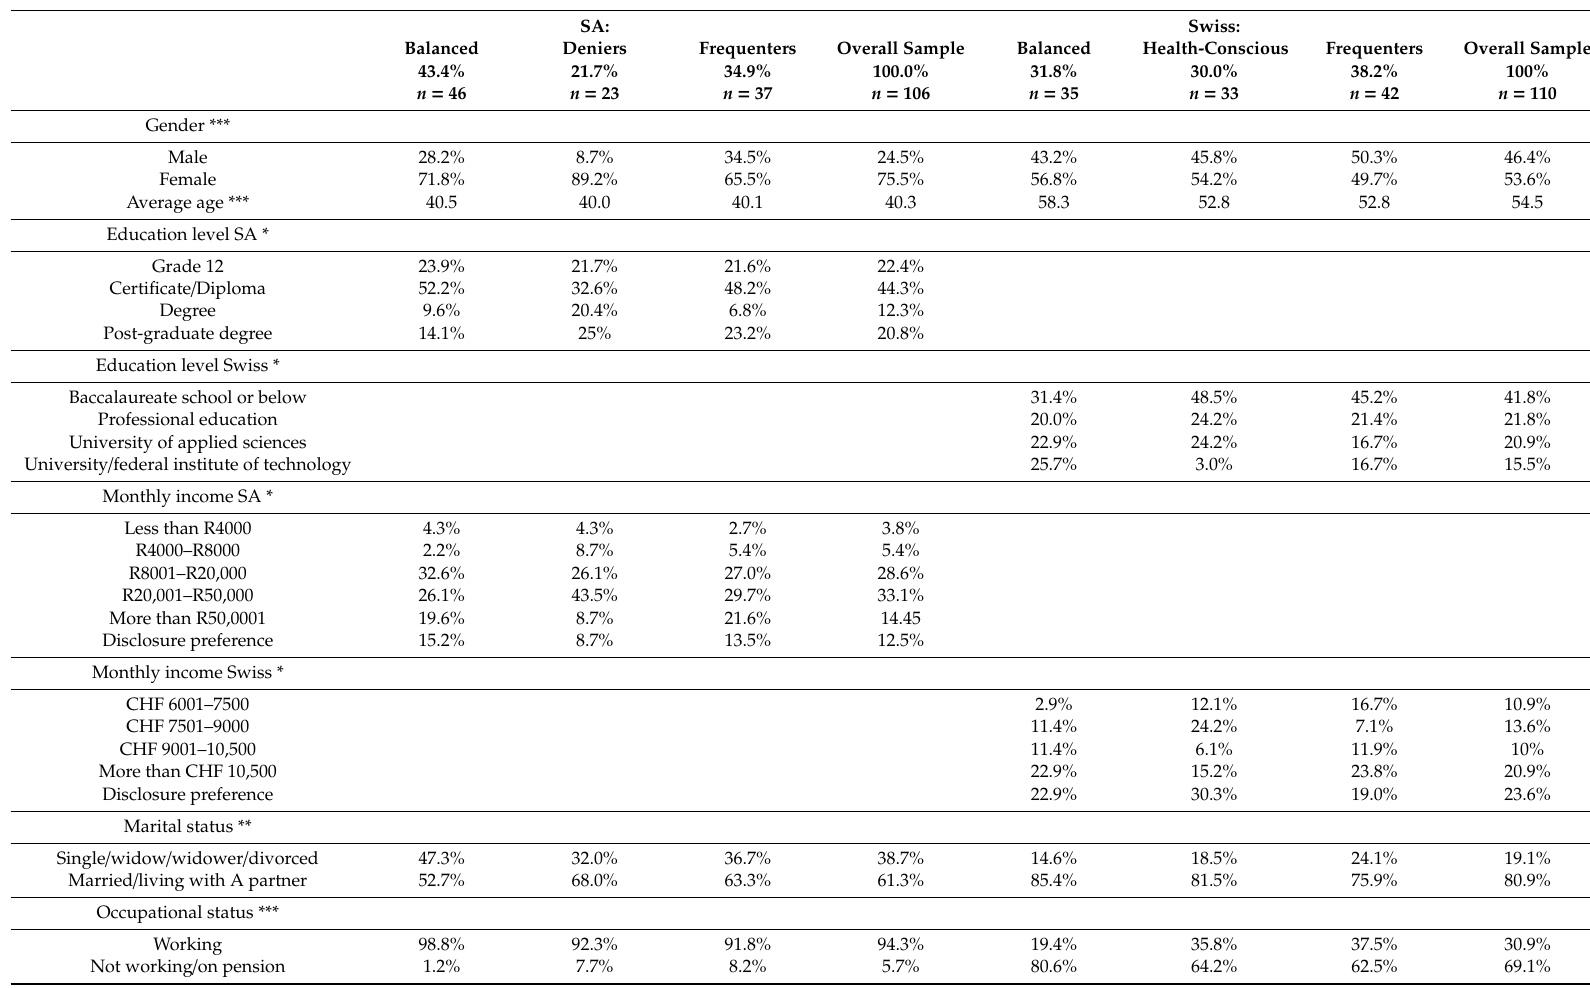
Table 2. Demographic features by clusters of the SA and Swiss